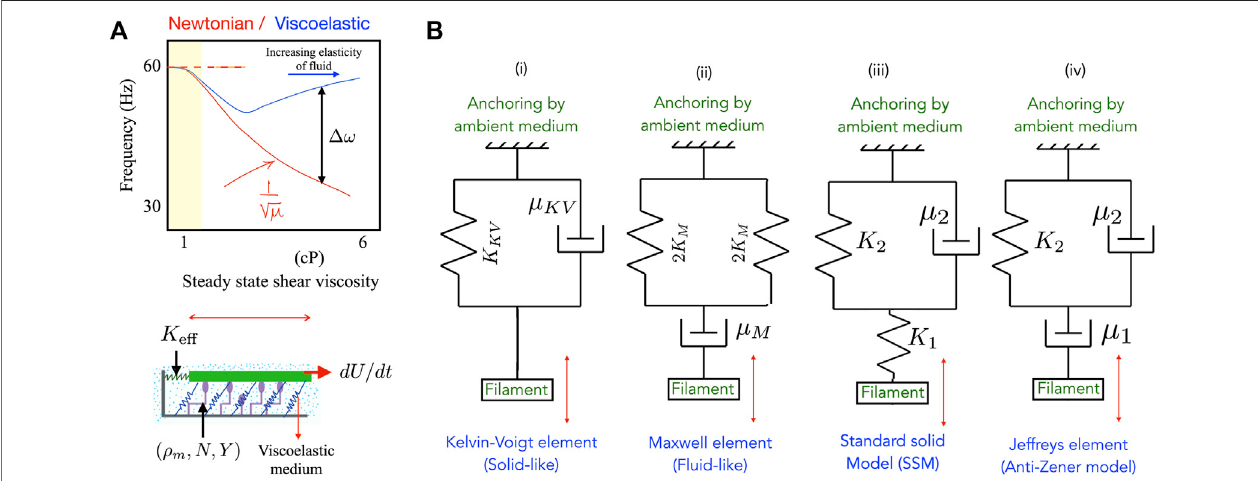
FIGURE 1 | (A) (Top) A schematic summarizing experimental observations of ciliary frequencies on bi-ciliated alga Chlamydomonas reinhardtii moving in model viscoelastic fl uids[9]madebyaddingpolymertoaNewtoniansolvent.Theobservedciliarybeatfrequencyinpolymeric fl uidsismuchhigherthaninNewtonian fl uidswith the same viscosity. (Bottom) Schematic of the animated motor- fi lament segment that forms the basis of the minimal motor- fi lament system. Active motors (purple) may be in one of two states – attached to the segment (in green) or detached. Passive cross-linkers are shown in blue and are treated as linearly elastic springs. The resistance to motion of the test segment exerted by its neighbors are combined into an effective elastic resistance (spring constant K eff ). The ambient medium in which the assembly is embedded is viscoelastic. In the minimal model this medium may be treated as a Maxwell medium or as a Kelvin-Voigt medium. (B) Representations of the viscoelastic ambient media considered in this article — here the spring stiffness K (if present) for each material is related to the elastic modulus of the material comprising the medium. (i) A Kelvin-Voigt material, (ii) a Maxwell fl uid, and (iii) a generalized standard solid element. The anti-Zener Jeffrey element in (iv) results in amore complicated relationship involving second derivatives of the strain rather than fi rst derivatives as in